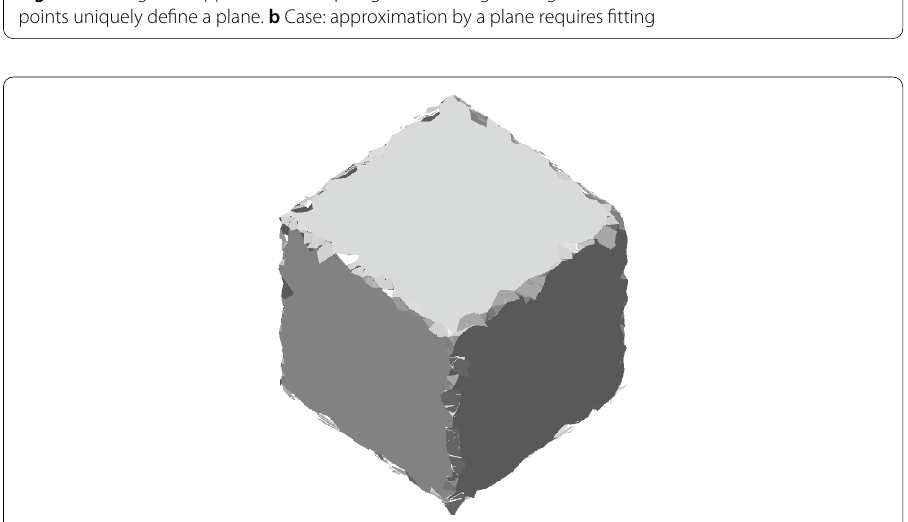
Fig. 18 Surface approximation of a cube immersed into a coarse background mesh to demonstrate the implicit description of sharp edges (feature lines are